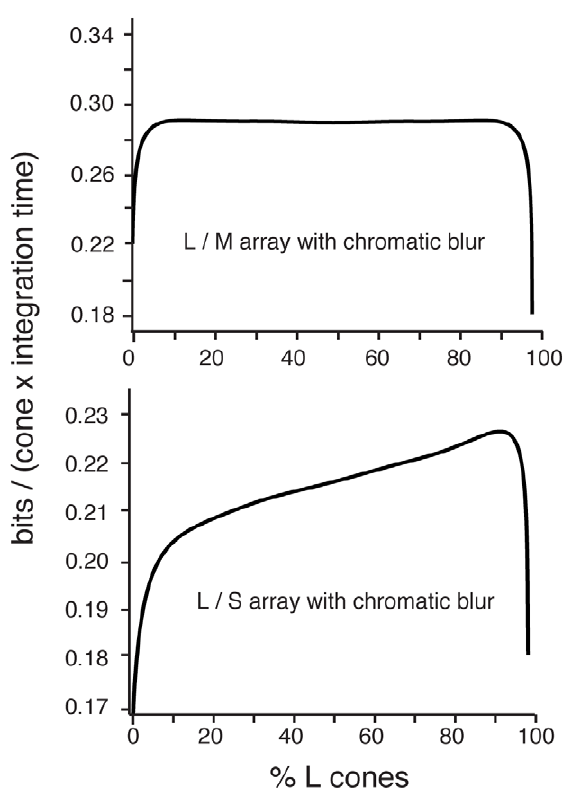
Figure 5. Optimal mosaic after accounting for chromatic aberration. (Top) Information represented by a mixed LM array as a function of the percentage of L cones in the array is shown on the top, and similarly for an LS array (Bottom). When we model the effects of chromatic blur due to human eye optics, information transmitted by a mixed LM array was largely independent of the L/M ratio, except when one type was extremely scarce. Information transmitted by a mixed LS array was highest with , 6% S